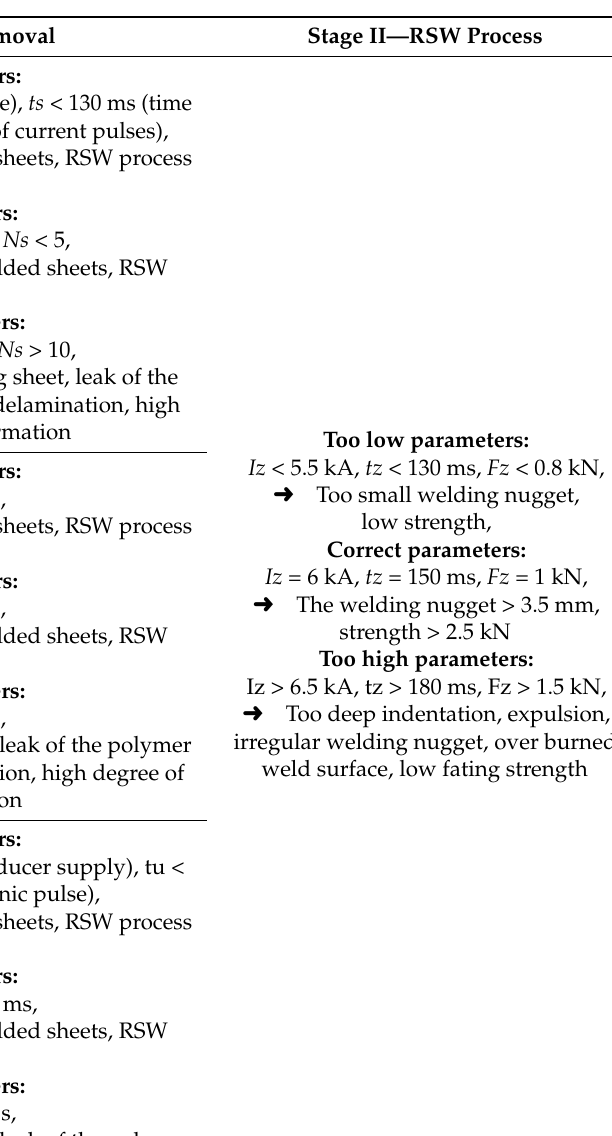
Table 7. The summary of the typical parameters of hybrid RSW